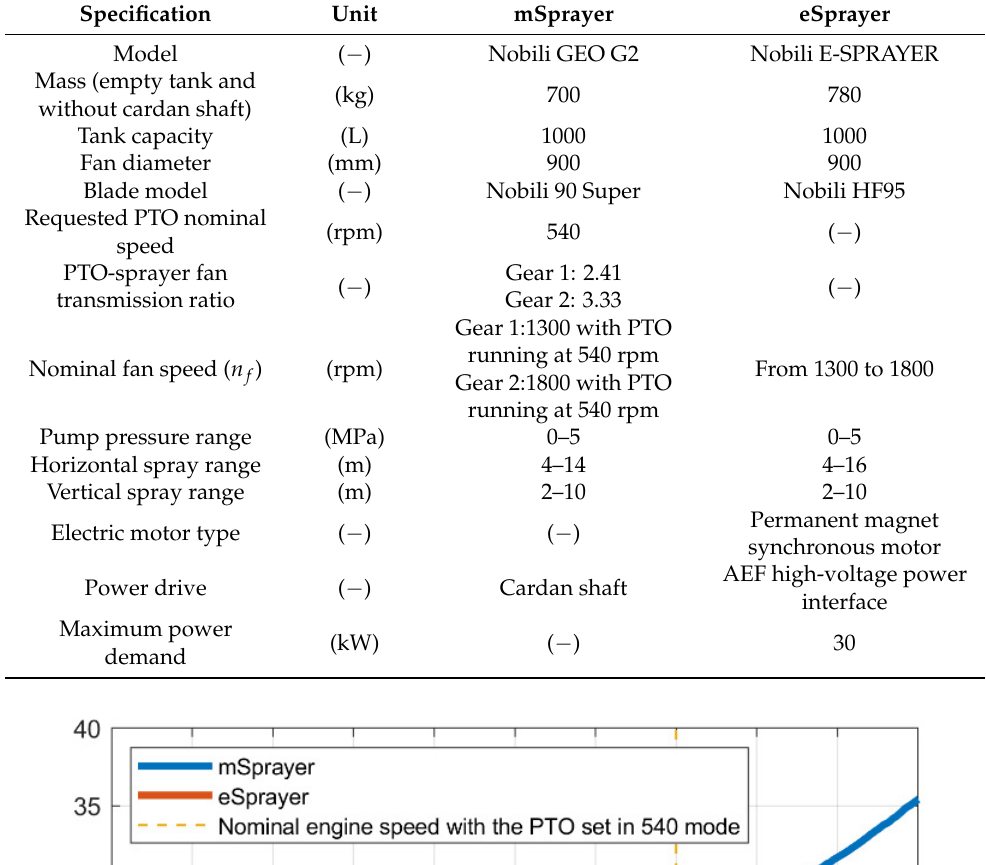
Table 3. mSprayer and eSprayer specifications.